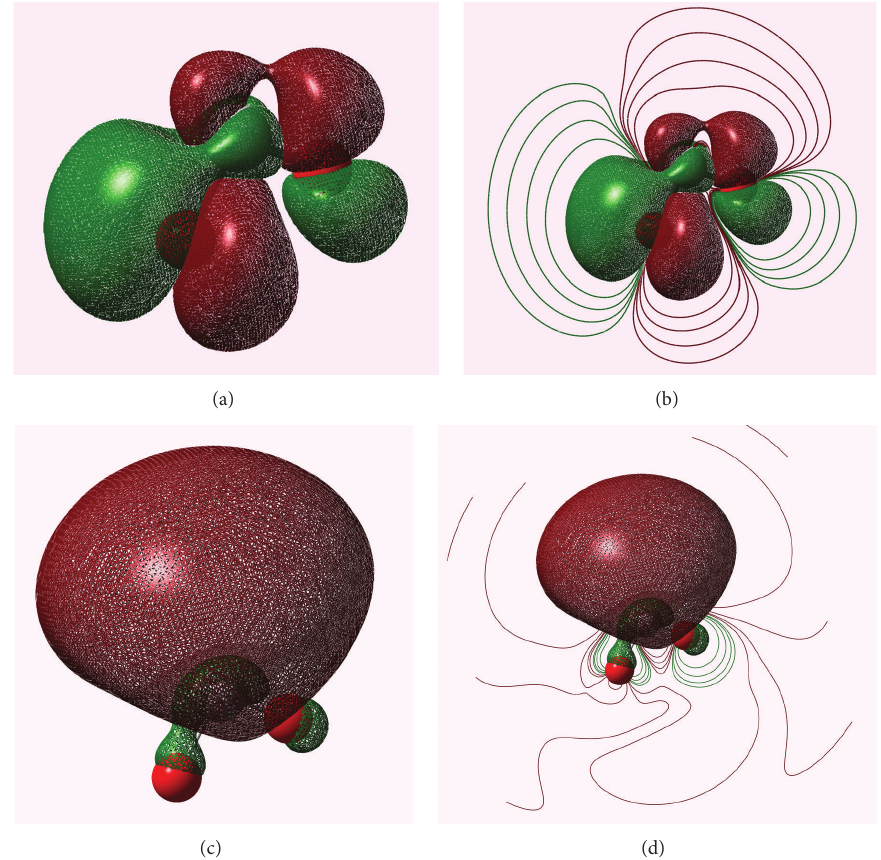
Figure 5: TiO 2 single molecule charge distributions in frontiers orbitals. The molecular orbitals were calculated at the TDDFT-B3LYP/6- 31G+(d,p) level of theory. The upper plots present HOMO. (a) TiO 2 HOMO 3D surface representing charge density. (b) TiO 2 HOMO surface superimposed on the 2D contour of charge density and the lower plots present surface of LUMO. (c) TiO 2 LUMO 3D surface representing charge density. (d) TiO 2 LUMO surface superimposed on the 2D contour of charge density. Shown are the contour surfaces of orbital amplitude 0.02 (red) and − 0.02 (green).